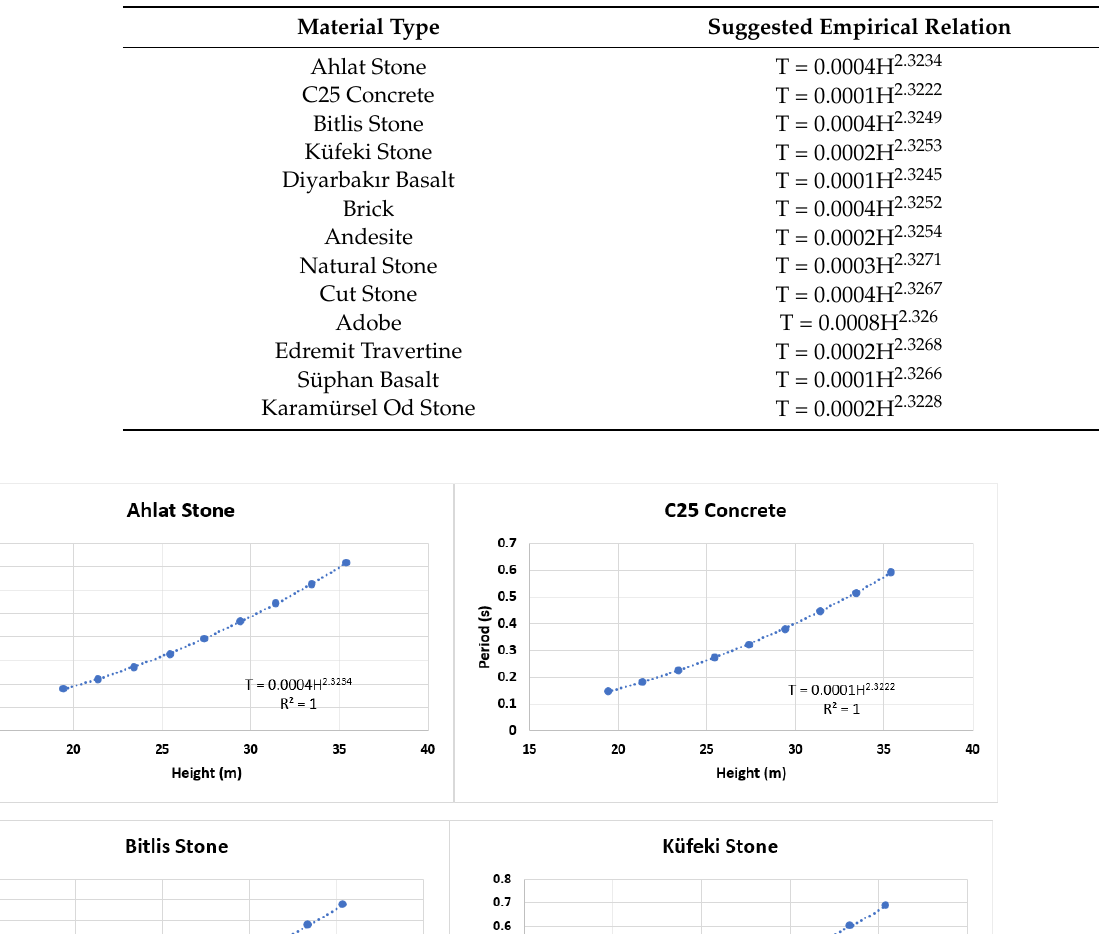
Table 8. Recommended period relations for the material